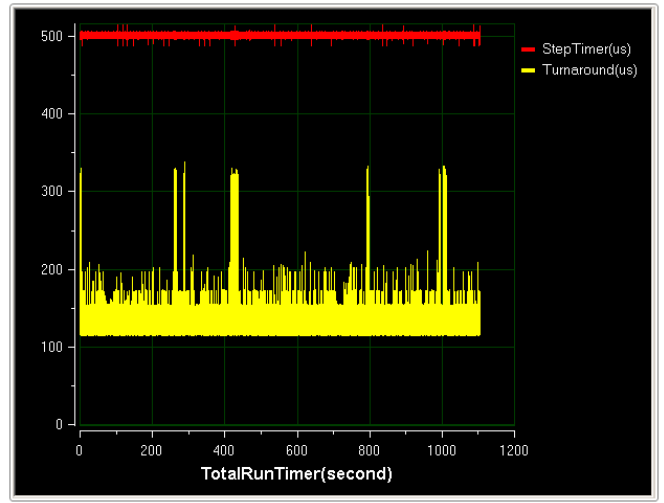
Figure 31. HiGale real-time simulator real-time simulation.